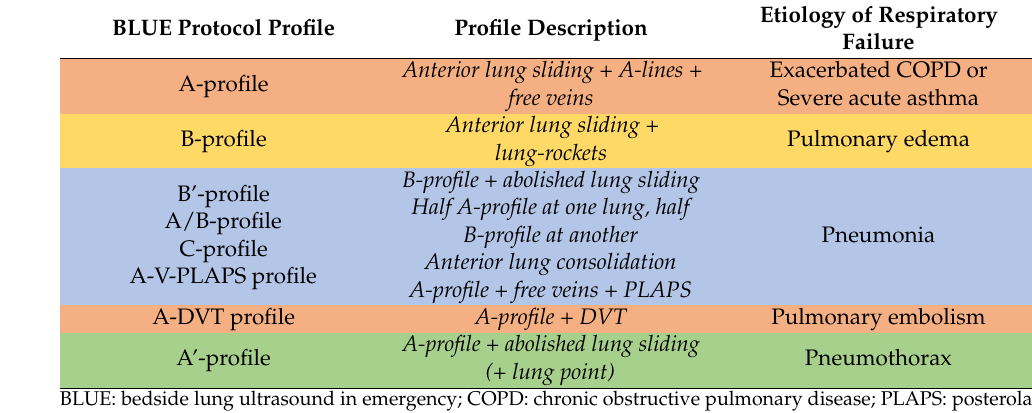
Table 1. The eight profiles of the BLUE protocol and their clinical interpretation [30].